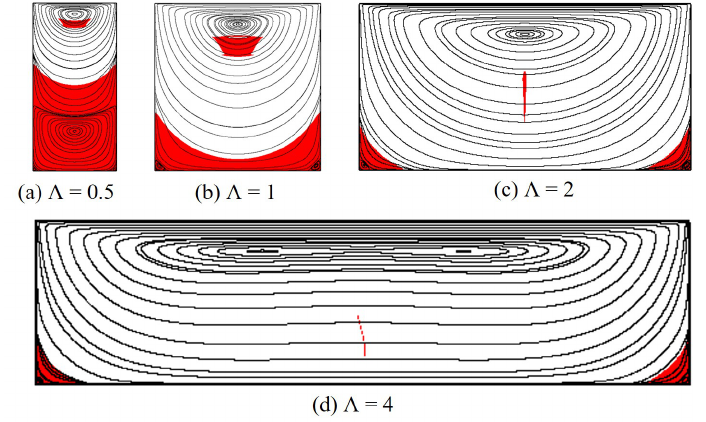
Figure 12. Flow morphology of the polymer gel in rectangular cavities with different aspect ratios at Od = 1